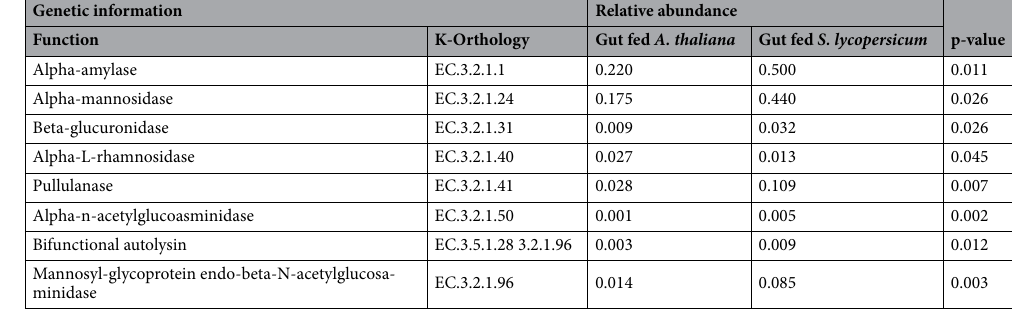
Table 4. Effect of restrictive diets on the relative abundances of predicted gut bacterial gene function within Trichoplusia ni fed with different plant diets . All displayed gene functions have been significantly increased or decreased as a result of restrictive diet administration to the Trichoplusia ni groups used in this study.